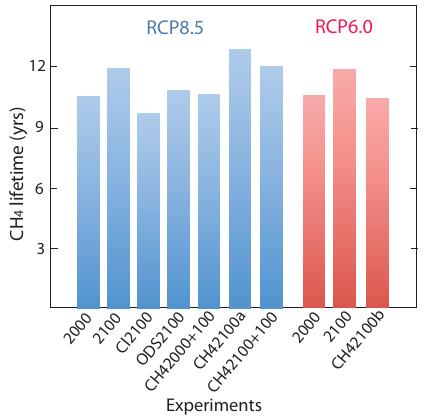
Fig. 4. Tropospheric chemical methane lifetime in the sensitivity experiments performed with the GISS-E2-R model.